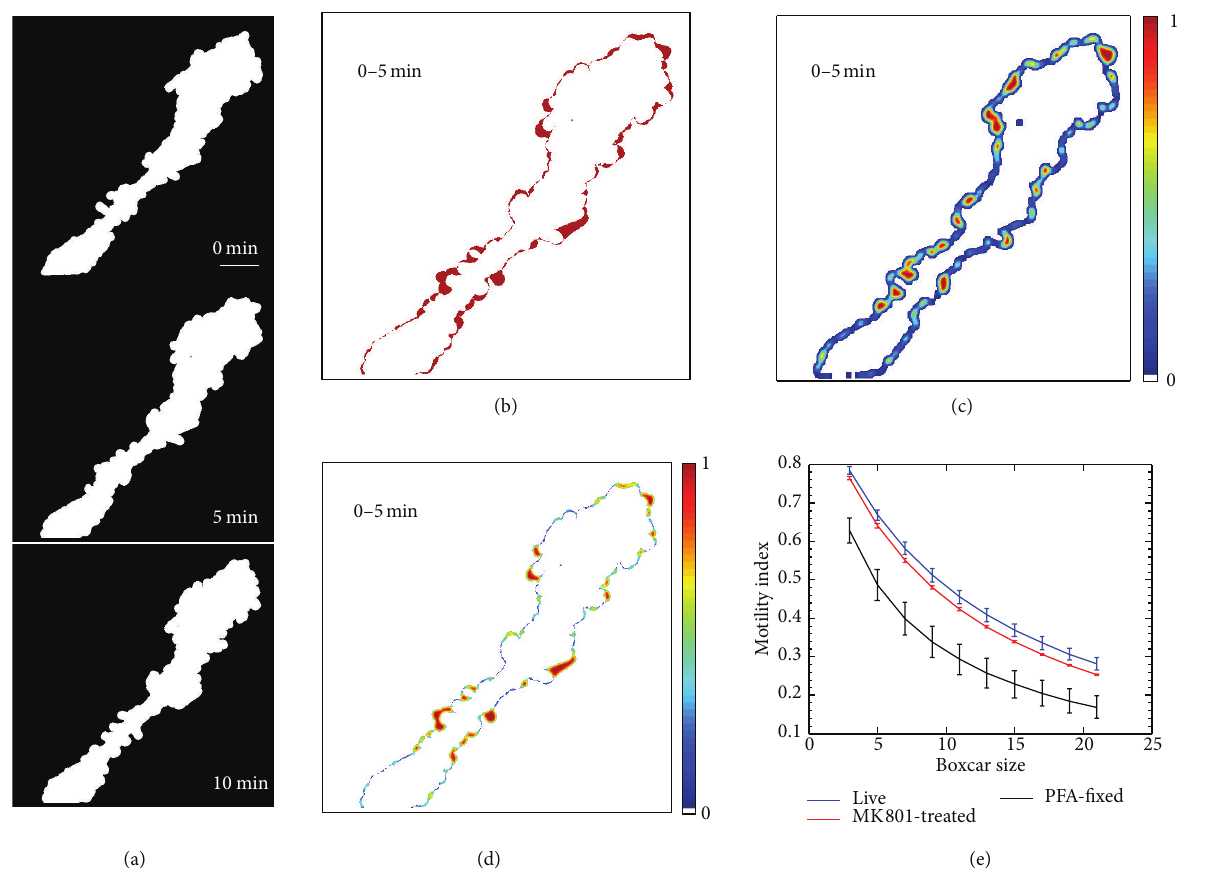
Figure 3: Analysis of pixel redistribution using boxcar averaging. (a) Preprocessed images from 0, 5, and 10 minutes time points. (b) Subtracting consecutive images from one another creates a map of the redistributed pixels between time points, shown in red. (c) Boxcar averaging of the pixel redistribution images from (b) using 9 × 9 pixel window. (d) Result of multiplication of the images in (b) and (c). The average of the nonzero pixel values in this image is used to calculate the cell motility index. (e) Plot of motility index values obtained for the datasets in Figures 5(c), 5(d), 6(c), and 6(d) using a range of different boxcar sizes. Motility values in the different conditions are most clearly separated when a 9 × 9 pixel boxcar size is used. Scale bar = 10 𝜇